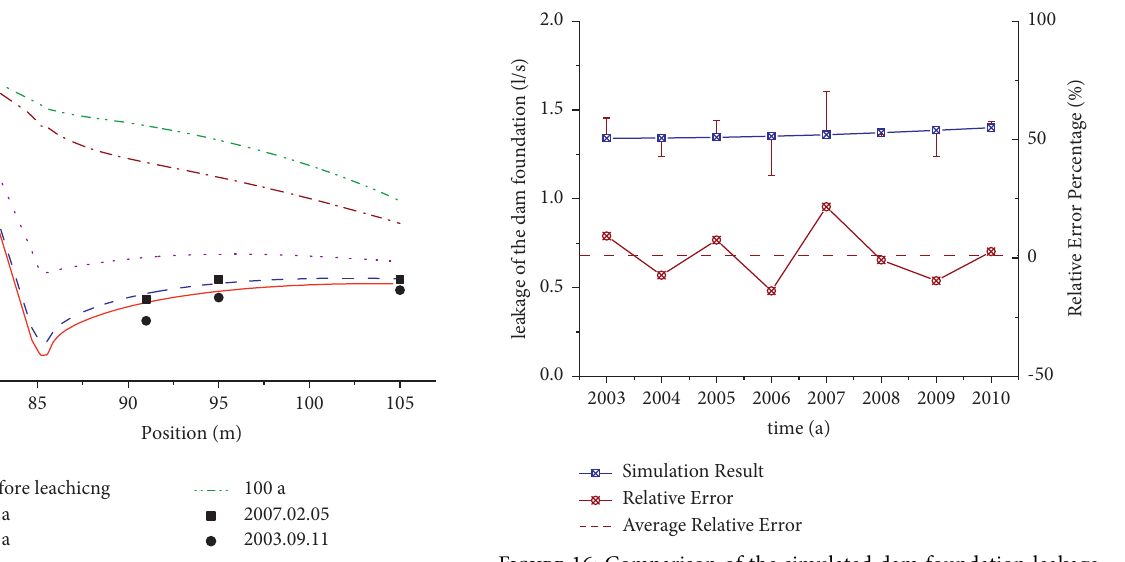
Figure 16: Comparison of the simulated dam foundation leakage quantity and monitored